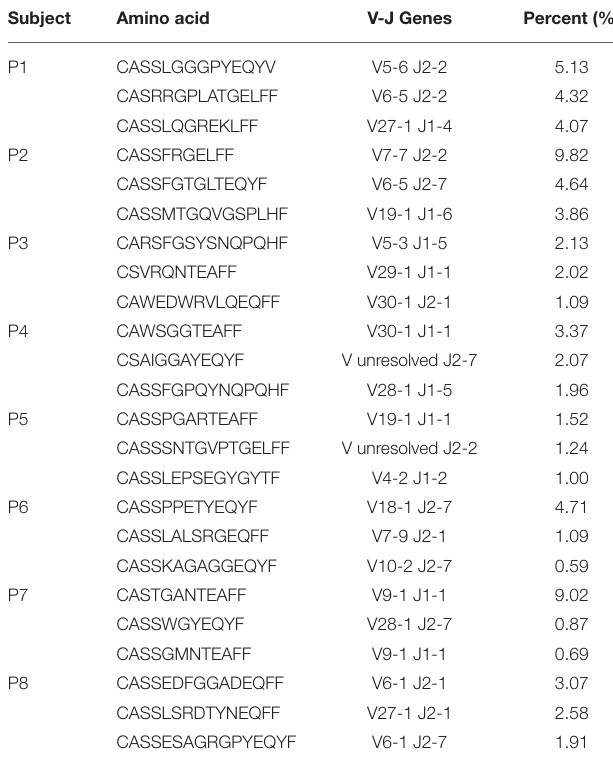
TABLE 4 | The amino-acid sequence, and corresponding TRBV-TRBJ pair, of the three most expanded T cell clones for each of the